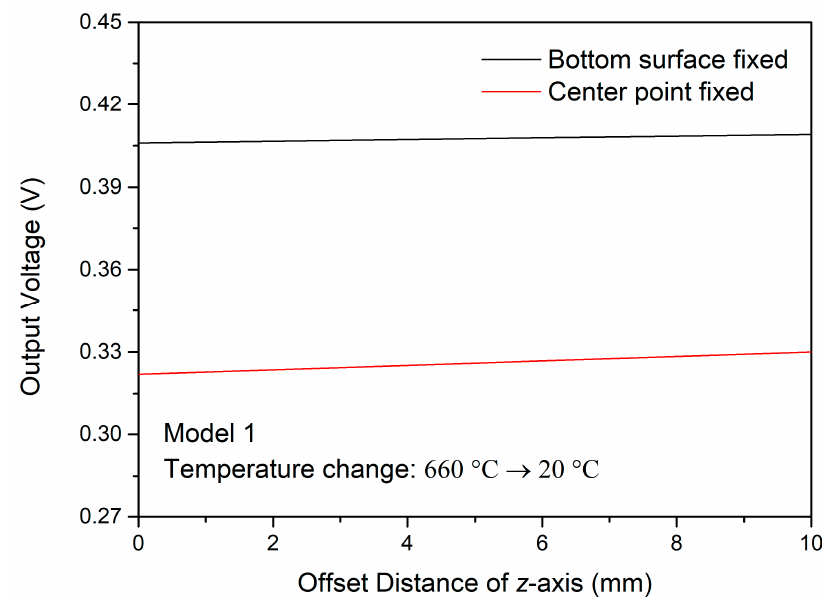
Figure 8. Relationships between the output voltage for the composite (Model 1) due to the concentrated load and the offset distance along the z axis ( x = 0 mm).